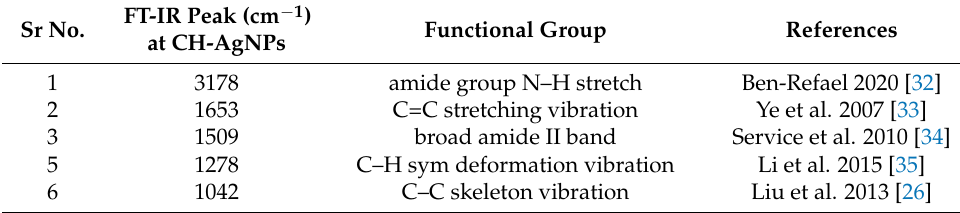
Table 4. FT ‐ IR analysis of CH ‐ AgNPs.